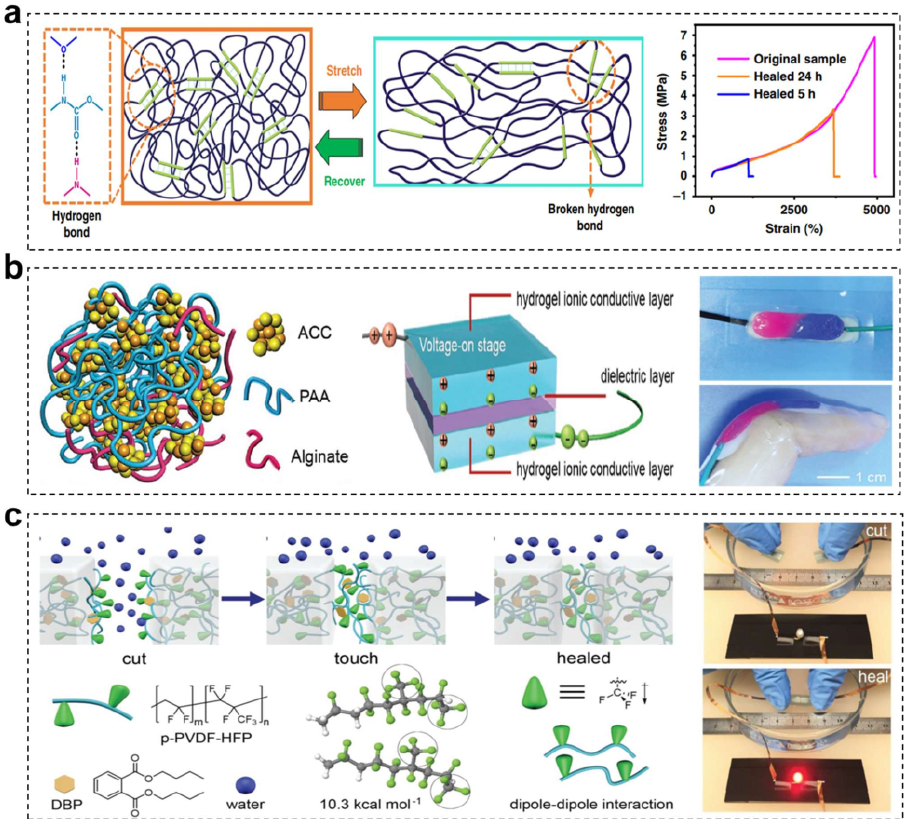
Figure 4. ( a ) Schematic illustration of the breaking and reforming of hydrogen bonding that resulting in high stretchability and desirable self-healing property. Stress-strain behavior of the self-healed PUA film with different healing time at 100 ◦ C. Reprinted with permission from ref. [143], Copyright 2019 Springer Nature. ( b ) Schematic structure of the amorphous calcium carbonate/ polyacrylic acid/alginate mineral hydrogel based on the dynamic chelation of the Ca 2+ and carboxylic groups, and the structural design of ionic skin. Photos of the autonomously healed hydrogel sensor and the self-healing hydrogel sensor attached to a bent finger. Reproduced with permission [144]. Copyright 2017, Wiley-VCH. ( c ) Underwater healing process of highly polar and hydrophobic fluorinated polymers with dynamic dipole-dipole interactions. The photos of completely severed conductor and electrical conductivity recovered immediately when contacted. Reproduced with permission